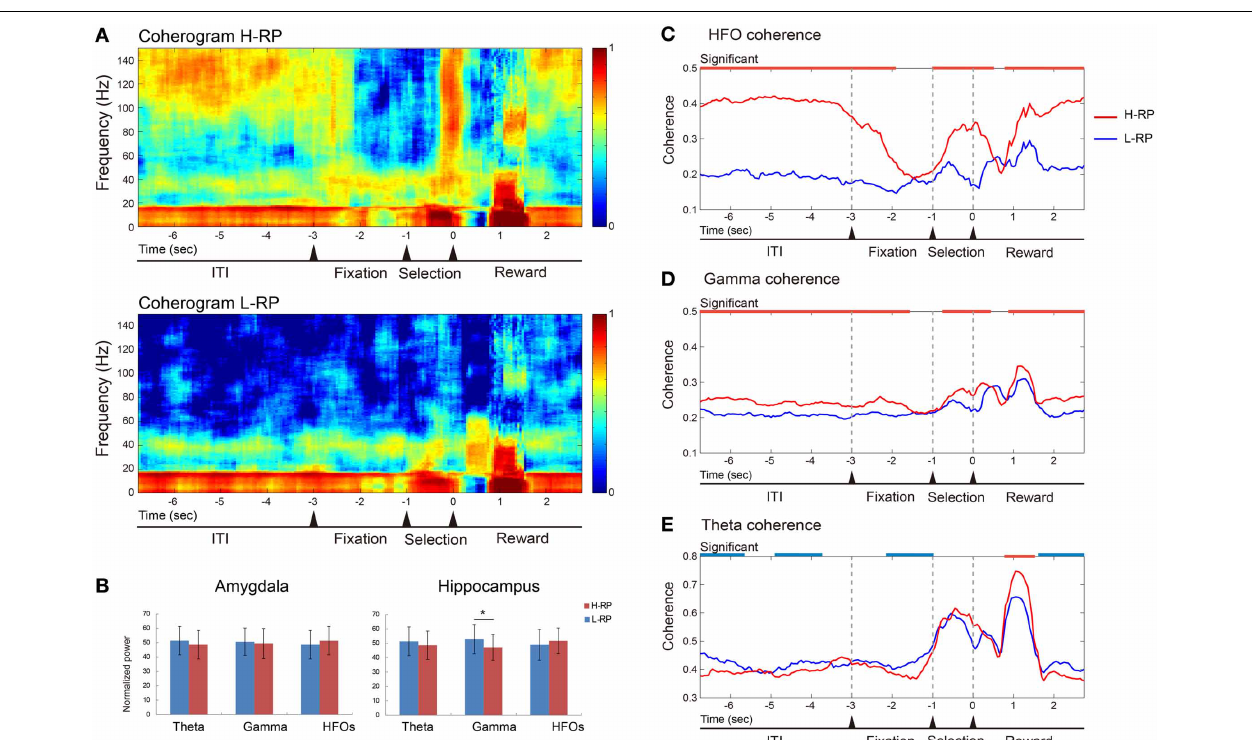
FIGURE 6 | Example of data of LFP coherence and power between the amygdala and the hippocampus. (A) Coherence presented as coherograms under the H-RP (upper) and L-RP (lower) conditions. The ordinates indicate the frequency of coherence. The abscissas indicate the time course and the time of zero is the time when the rat poked its nose into the selected hole. Colors in the graph indicate the strength of coherence. (B) Averaged powers presented as normalized PSDs between H-RP and L-RP conditions in the amygdala (left) and hippocampus (right). Each of the three different bands of oscillation (theta, gamma, and HFOs) was compared. The asterisk indicates a significant difference between H-RP and L-RP. (C) HFO coherences between the amygdala and the